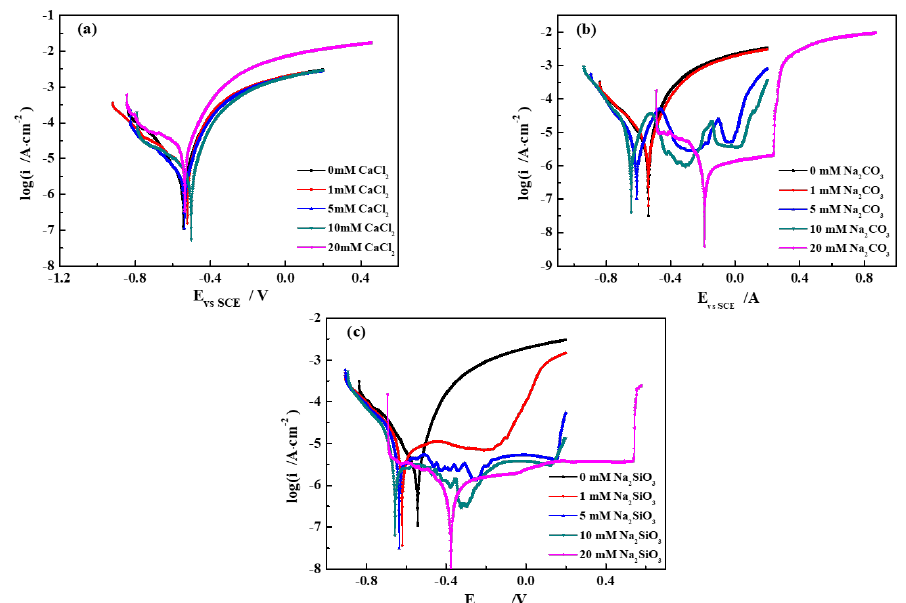
Figure 1. Polarization curves of pure iron in different simulated groundwaters at 40 °C. ( a ) SG + CaCl 2 ; ( b ) SG + Na 2 CO 3 ; ( c ) SG + Na 2 SiO 3 . Table 3. Electrochemical parameters obtained from the fitted curves.